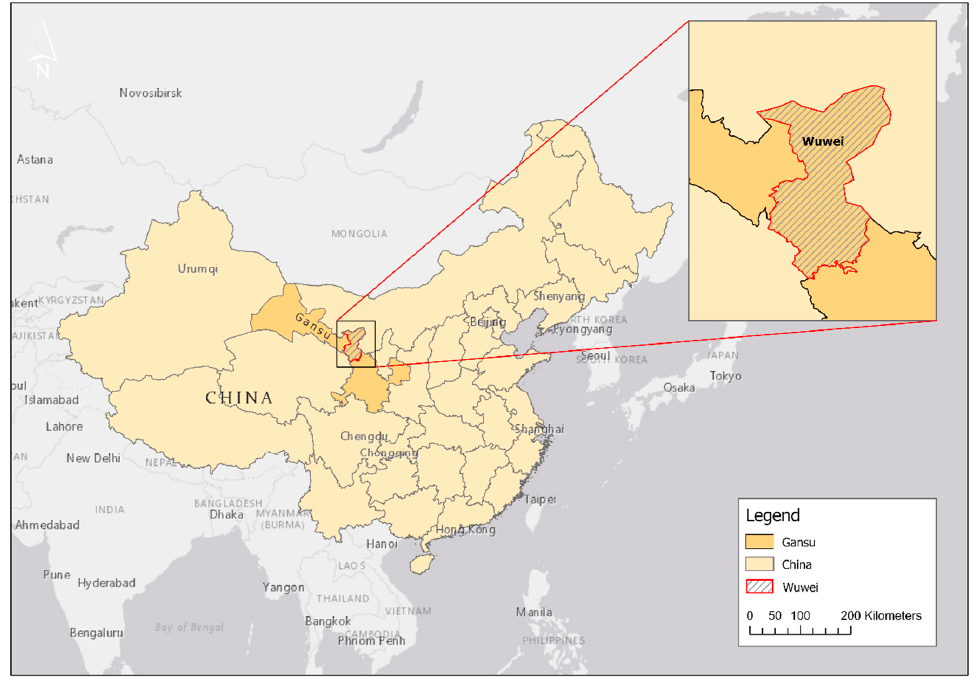
Figure 2. Location of Wuwei in Gansu Province, China (own map, administrative boundaries are based on Database of Global Administrative Areas (GADM